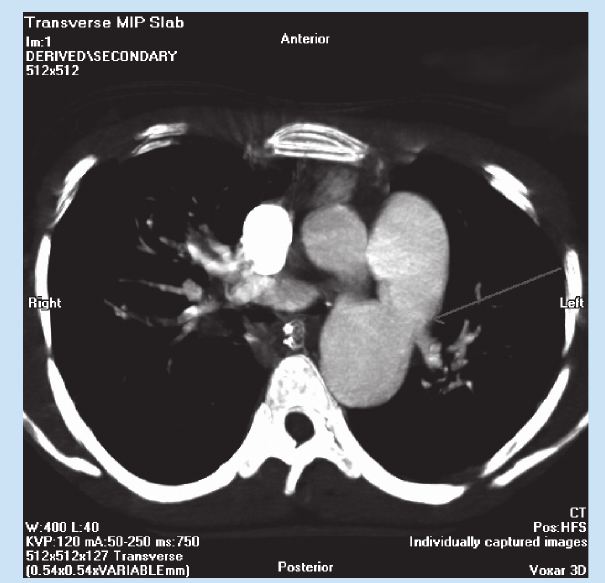
Fig. 1. Multislice spiral pulmonary angiogram: Axial maximum intensity projection; arrow points to PDA.